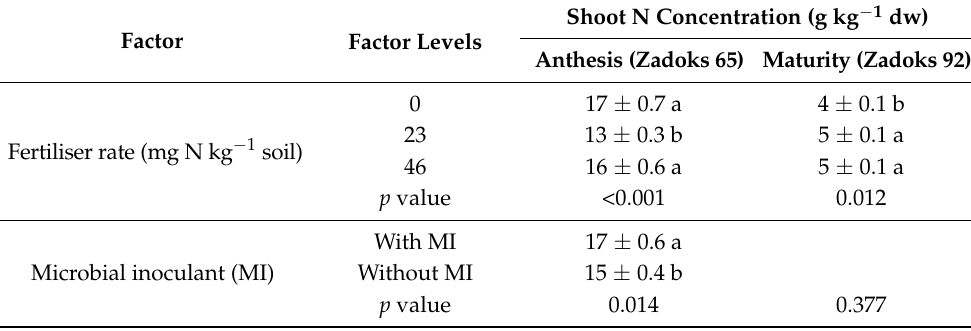
Table 2. Shoot N concentration as influenced by fertiliser rate and microbial inoculant (MI) (mean ± SE) at anthesis and maturity. Mean values for a given treatment factor within a column followed by different letters differ significantly. Three-way ANOVA (Table 1) showed no significant interaction, with the main effects of fertiliser rate and MI being significant at anthesis and only fertiliser rate at maturity. The data on each fertiliser rate were averaged across two fertiliser types and two MI treatments (n = 16). The data on individual MI were averaged across three fertiliser rates and two fertiliser types (n = 24). dw, dry